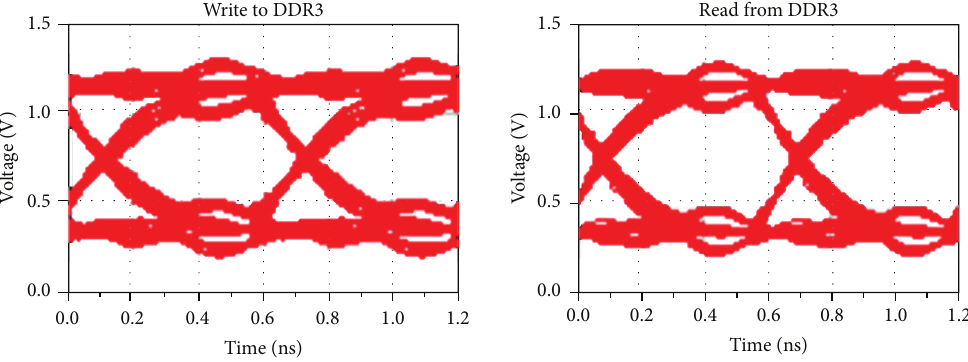
Figure 8: Simulation eye diagram for the general design.